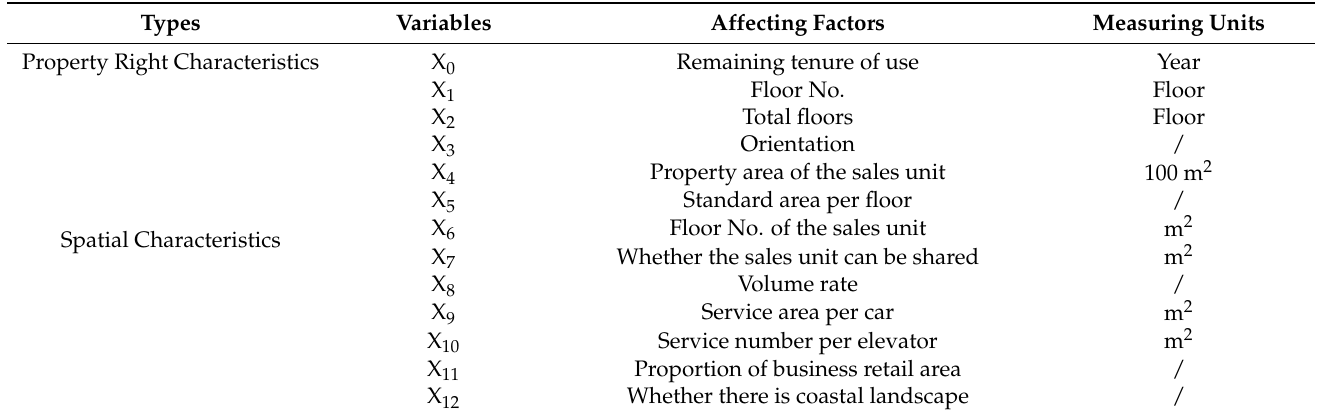
Table 2. Factors affecting office spatial value.